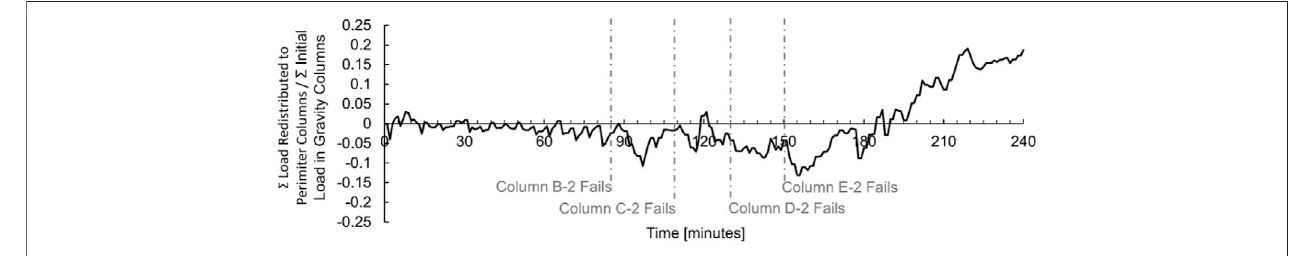
FIGURE 10 | The sum of force redistributed to the perimeter columns normalized by the initial load carried by all eight gravity columns in Fire Scenario #2.